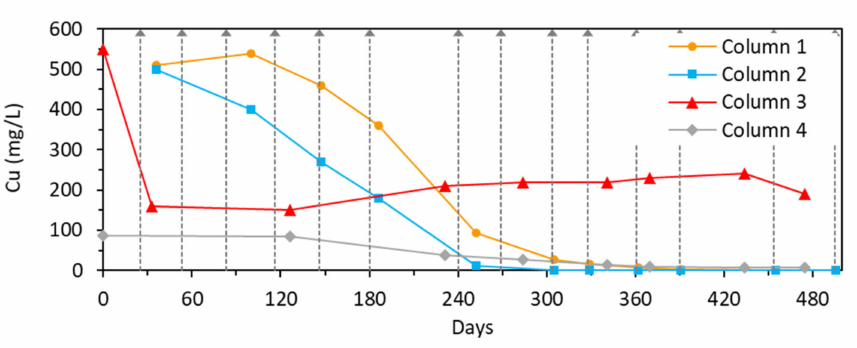
Figure 9. Concentrations of Cu in the column leachates. Vertical dashed lines mark the beginning of each wetting-drying